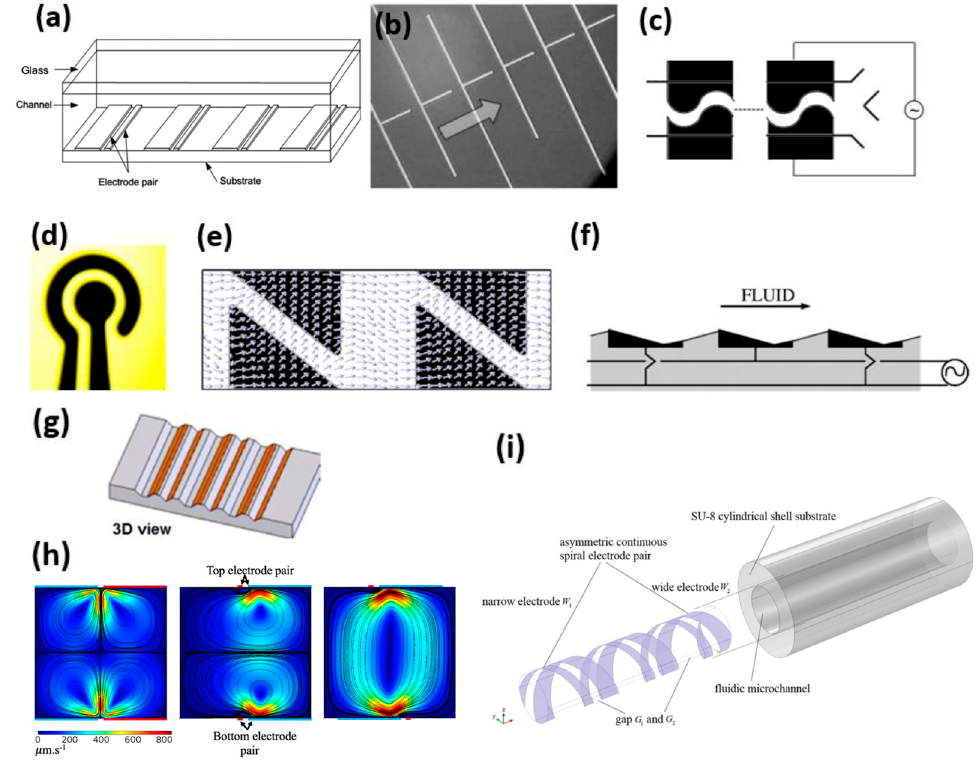
Figure 1. Schematic of different electrode geometries. ( a – e ) 2D Electrodes: ( a ) asymmetric rectangular, ( b ) orthogonal, ( c ) meandering, ( d ) concentric, and ( e ) triangular. ( f – i ) 3D Electrodes: ( f ) 3D electrode array, ( g ) microgrooved configuration, ( h ) electrodes facing each other, and ( i ) spiral design. Reproduced with permission from [56,60,62,69,77,85,93–95].